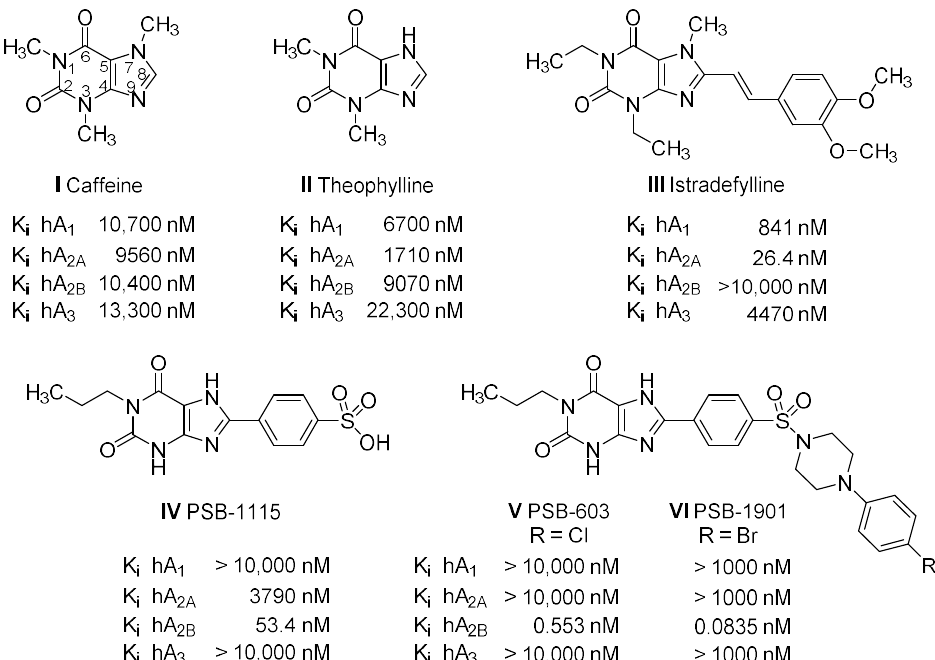
Figure 1. Chemical structures of selected AR antagonists (h = human) [18,23].